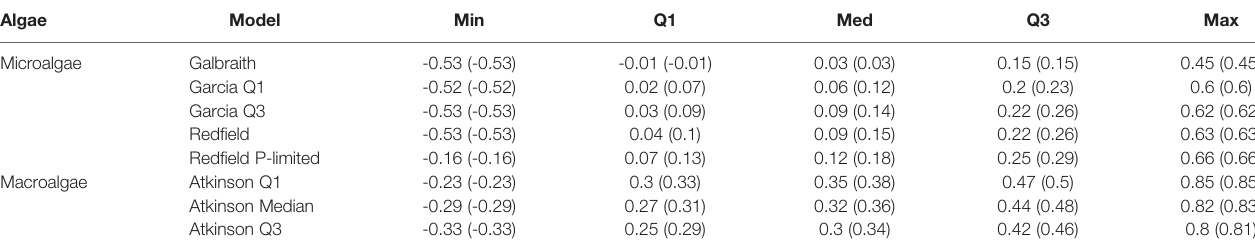
TABLE 2 | Summary statistics of carbon dioxide removal potential from microalgae and macroalgae models across the global grid (tons CO 2 km -2 yr -1 ).